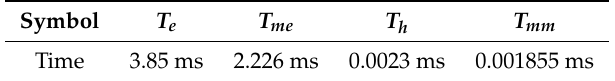
Table 4. The performing time of cryptographic operations (adapted from